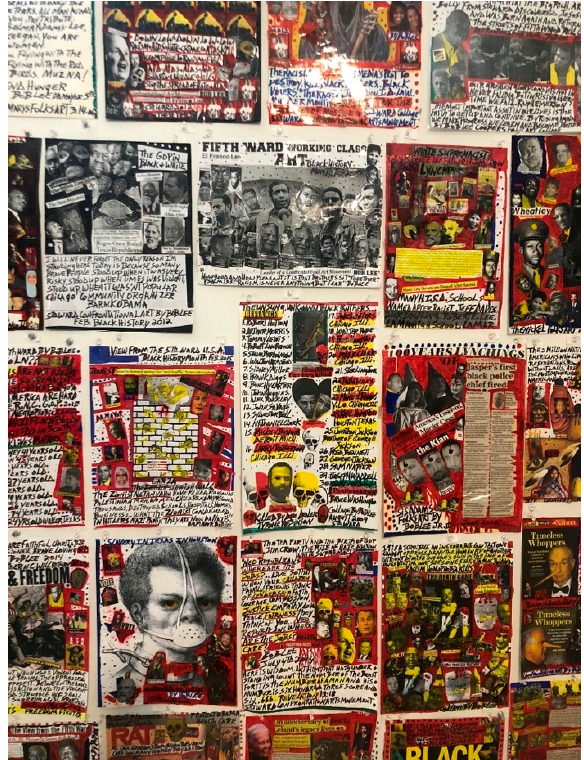
Figure 11. Collages of Black resistance around the world and in Fifth Ward by Bob Lee. Image courtesy of Mystic Lyon.